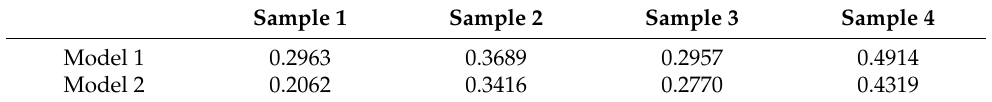
Figure 6. Comparison results of the two models and the real results: ( a ) sample 1; ( b ) sample 2; ( c ) sample 3; ( d ) sample 4. Table 6. Variance of the difference between the predicted value and real